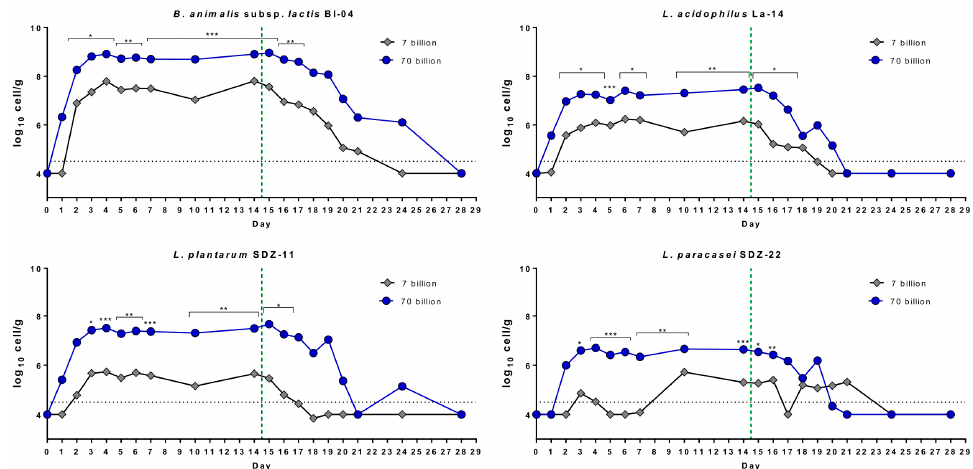
Figure 2. Mean recovery per day of the four probiotic strains simultaneously administered to volunteers during the ECoCePPI study with a multistrain formulation at two doses. Data come from qPCR experiments with strain-specific primers. Statistics according to two-tailed unpaired t -test; *, p < 0.05; **, p < 0.01; ***, p < 0.001.